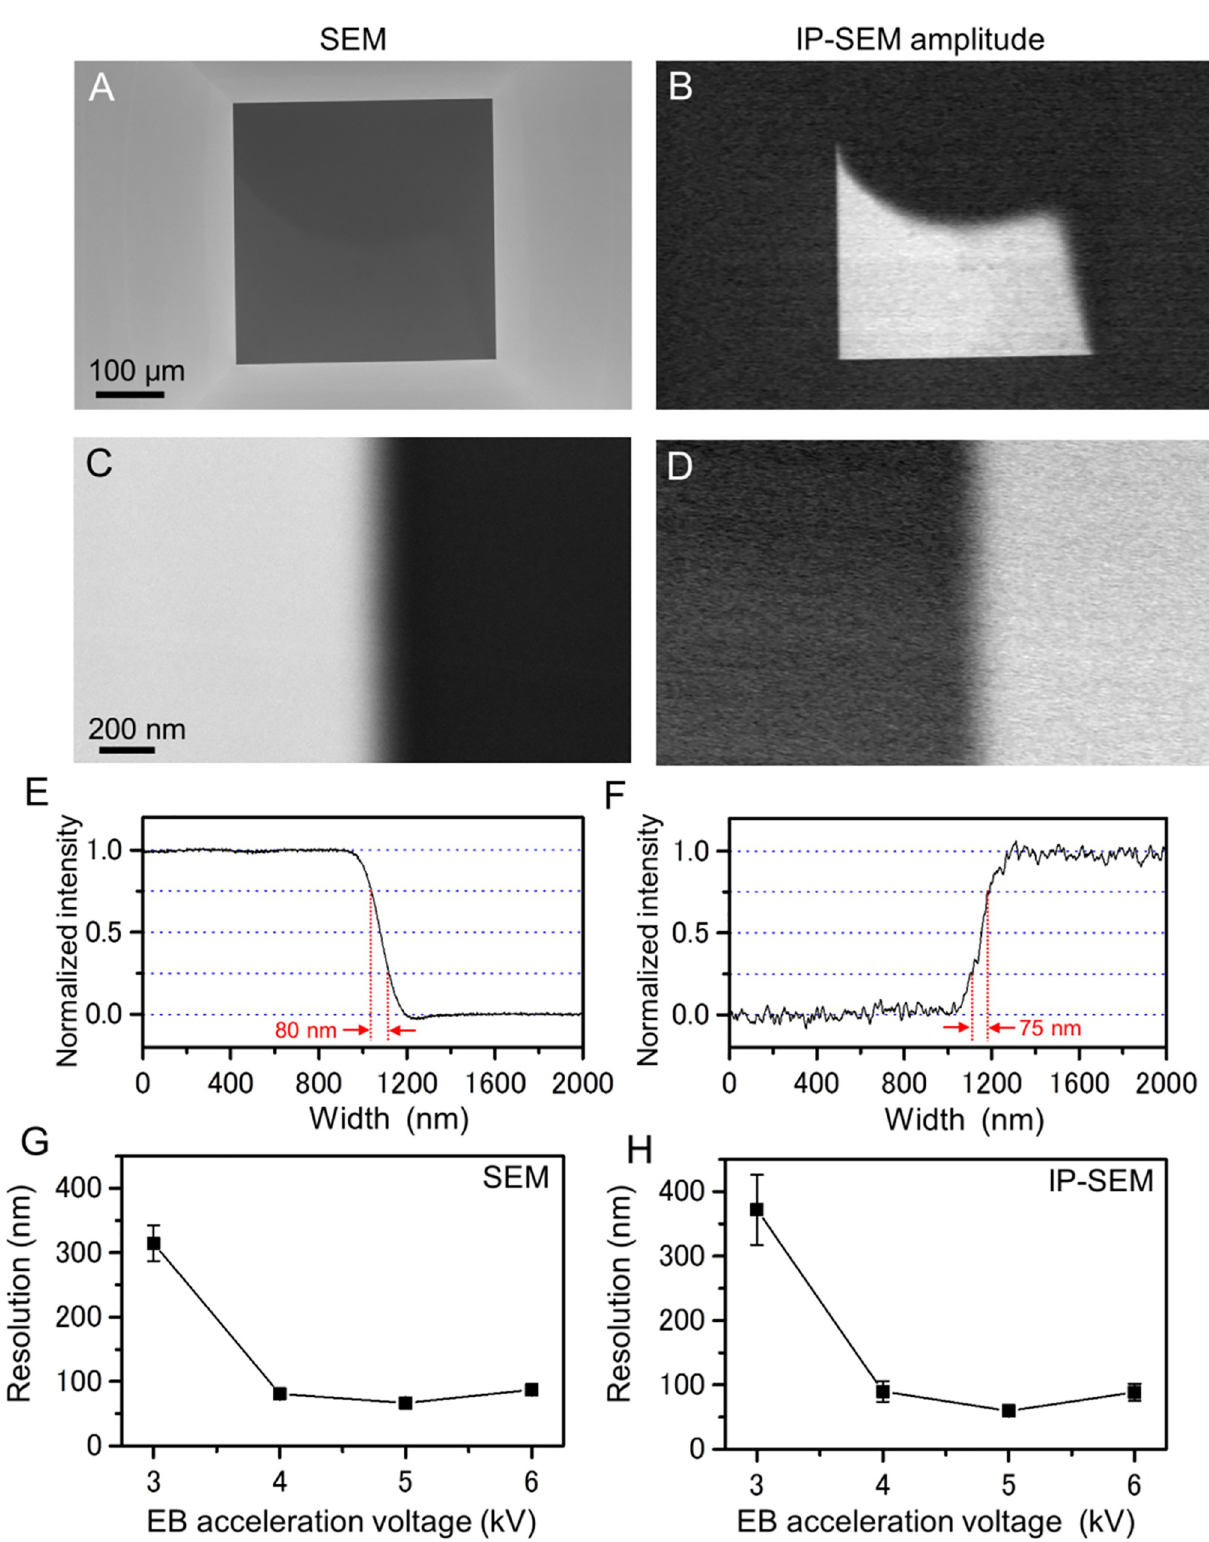
Fig 2. Comparison of spatial resolution between SEM and IP-SEM. (A) A SEM image of the pure water in the atmospheric holder by the secondary electron signal. (B) Simultaneous observation of a current amplitude image by the IP-SEM system (EB accelerating voltage 4 kV, EB current 140 pA, input frequency 50 kHz, magnification 150 × ). (C) A high-magnification image of the SiN film edge by SEM, scanned at 60,000 × . (D) Simultaneous